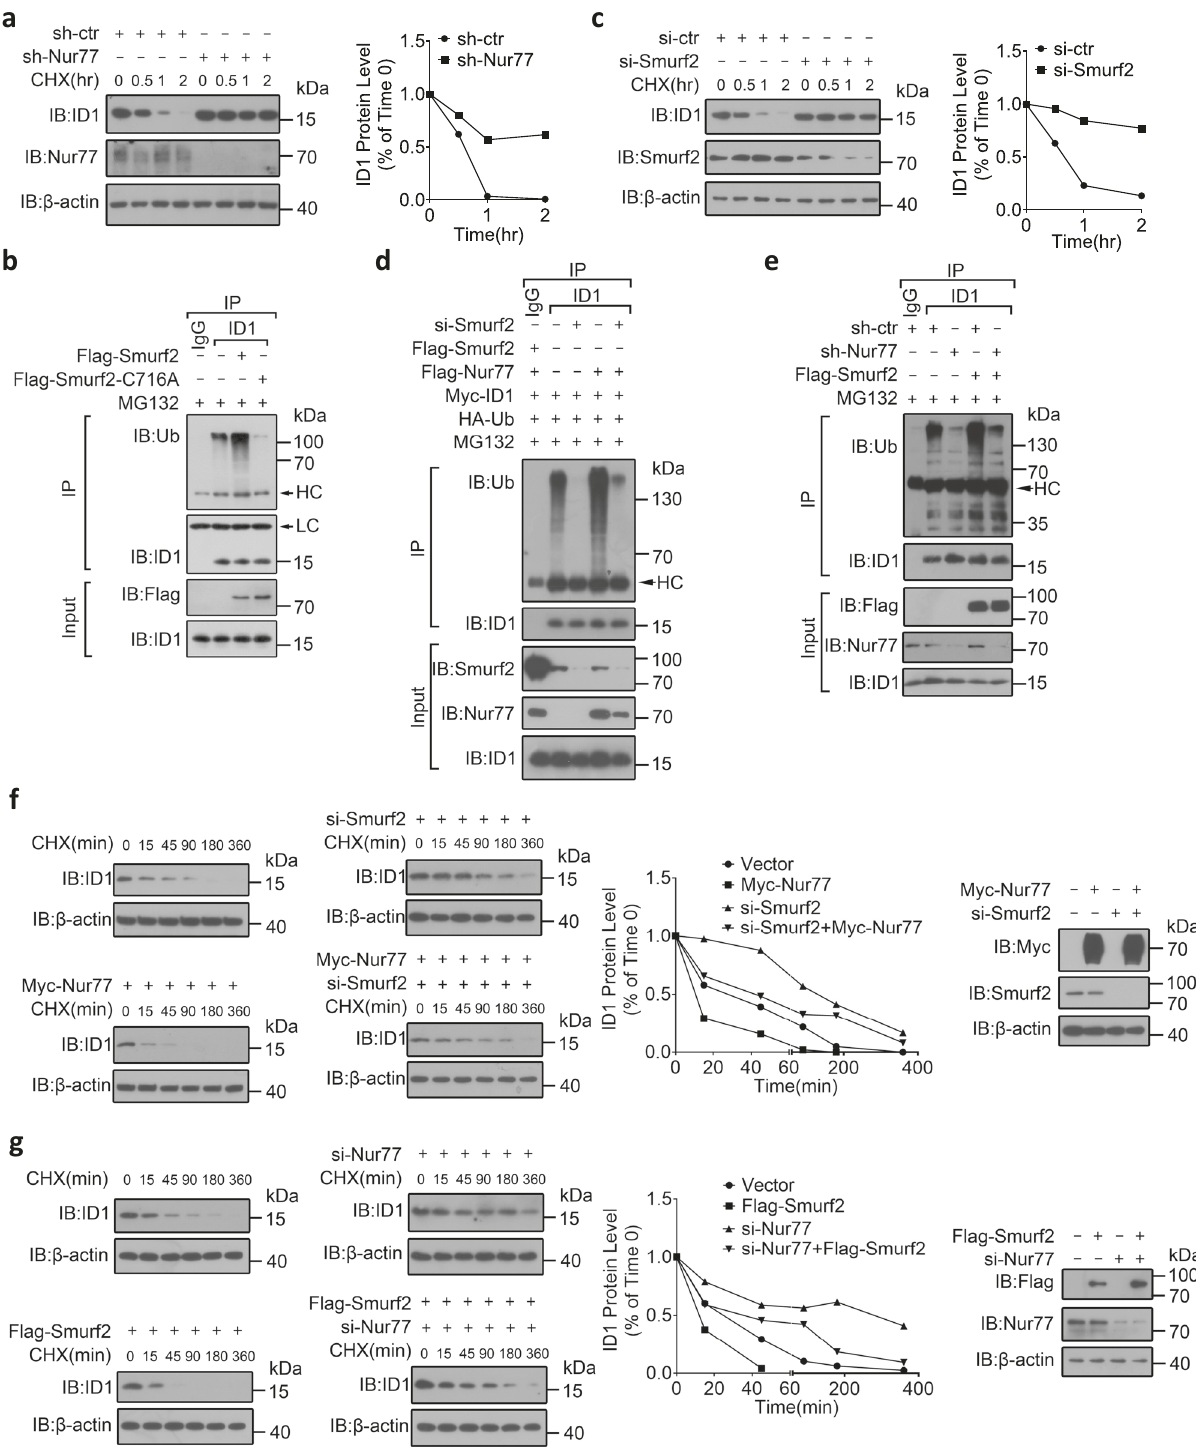
Fig. 2 Nur77 post-translationally downregulates ID1 through mediating its association with and ubiquitylation by Smurf2. a , c , f , g SW620 cells were transfected with the indicated expression plasmids, shRNAs, or siRNAs followed by cycloheximide (CHX) (10 μ M) treatment for the indicated time. Protein expressions were examined by IB. The anti-ID1 antibody signal normalized relative to the anti-actin signal is expressed as a percentage of that present at the start of the chase. si-ctr control siRNA, si-Nur77 Nur77 siRNA, si-Smurf2 Smurf2 siRNA, sh-ctr control shRNA, sh-Nur77 Nur77 shRNA, hr hour, min minute. b , d , e SW620 cells transfected with the indicated expression plasmids, shRNAs, or siRNAs were treated with MG132 (20 μ M) for 2 h. ID1 ubiquitylation was examined by IP with anti-ID1 antibody and IB with anti-ubiquitin (Ub) antibody. LC light chain, HC heavy chain. Data represent at least two independent experiments. Source data are provided as Source Data fi